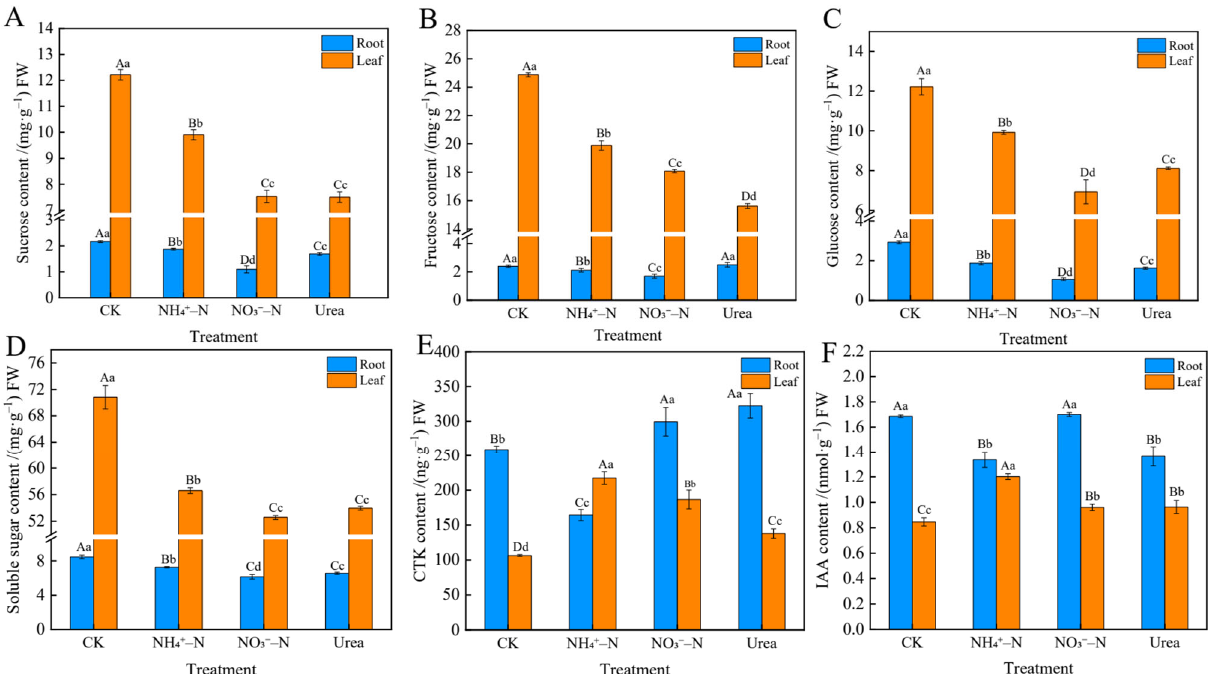
Figure 5. E ff ects of di ff erent N forms on sugar ( A – D ) and endogenous hormone contents ( E – F ) in Figure 5. Effects of different N forms on sugar ( A – D ) and endogenous hormone contents ( E , F ) in roots and leaves. The data presented are the means ± SDs ( n = 3). Di ff erent le tt ers show signi fi cant roots and leaves. The data presented are the means ± SDs ( n = 3). Different letters show significant di ff erences between treatments (uppercase le tt ers indicate p < 0.01, lowercase le tt ers indicate p < differences between treatments (uppercase letters indicate p < 0.01, lowercase letters indicate p < 0.05).